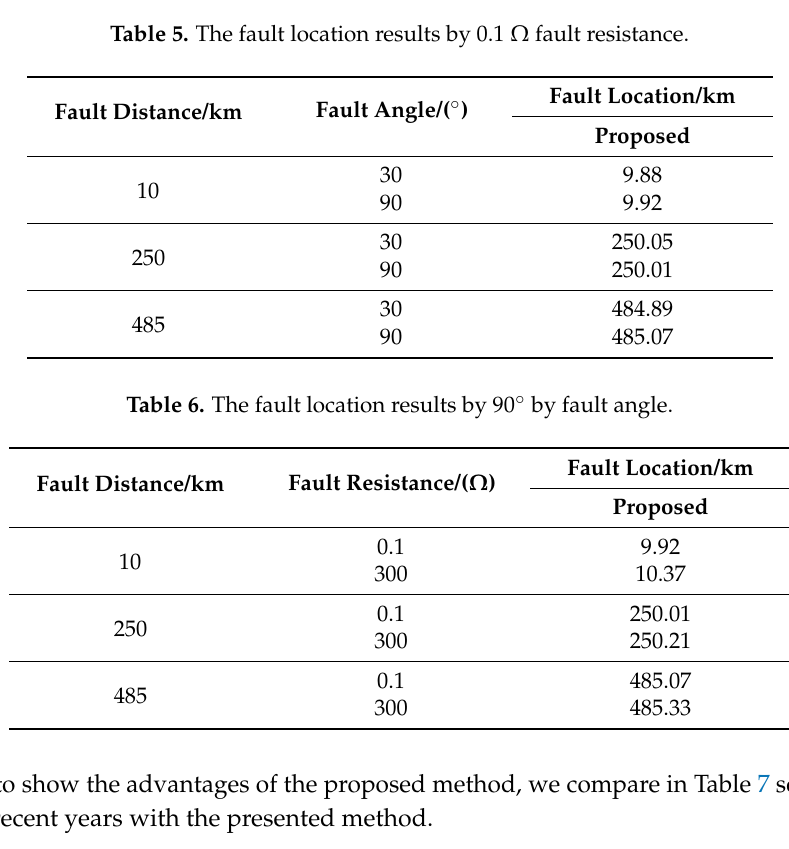
Table 7. A comparison with the state-of-the-art fault location